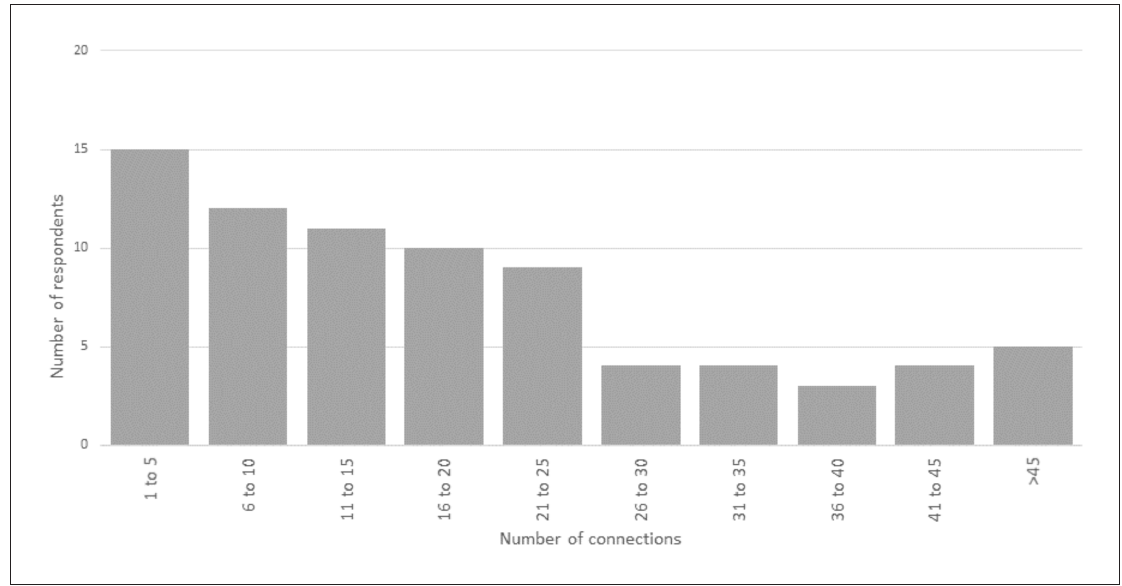
Figure 3 The number of connections for individuals in the citizen science practitioner network (75 respondents). Individuals have, on average, 19.5 connections with others in the network. The most connected person had 84 connections, 65 more than the network